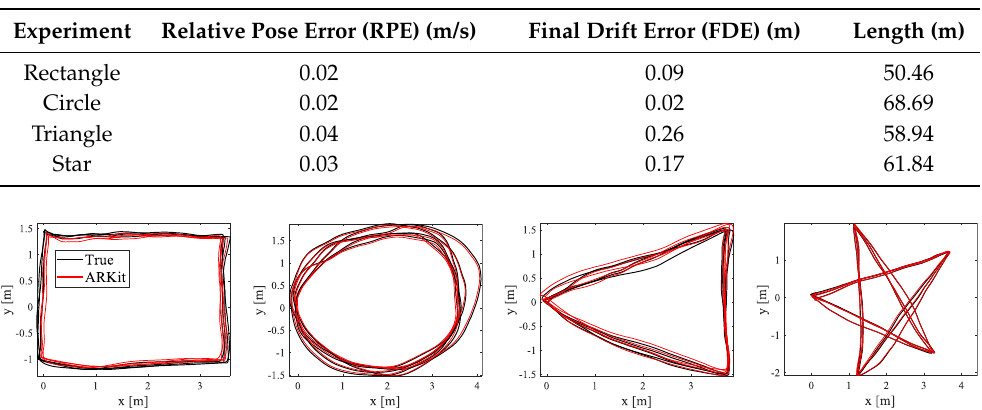
Table 2. Quantitative evaluation results for Apple ARKit.